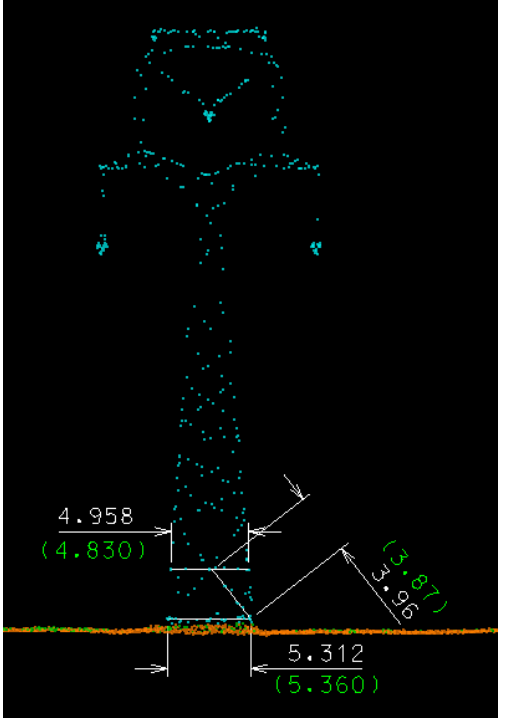
Figure 9. The comparison of the 400 kV support tower beam dimensions obtained from the scanned point cloud in TerraScan software ( white color ) and by the real measurement ( green color ).